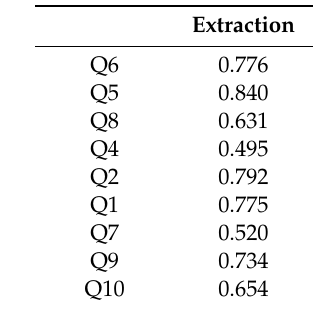
Table A4. Communalities.